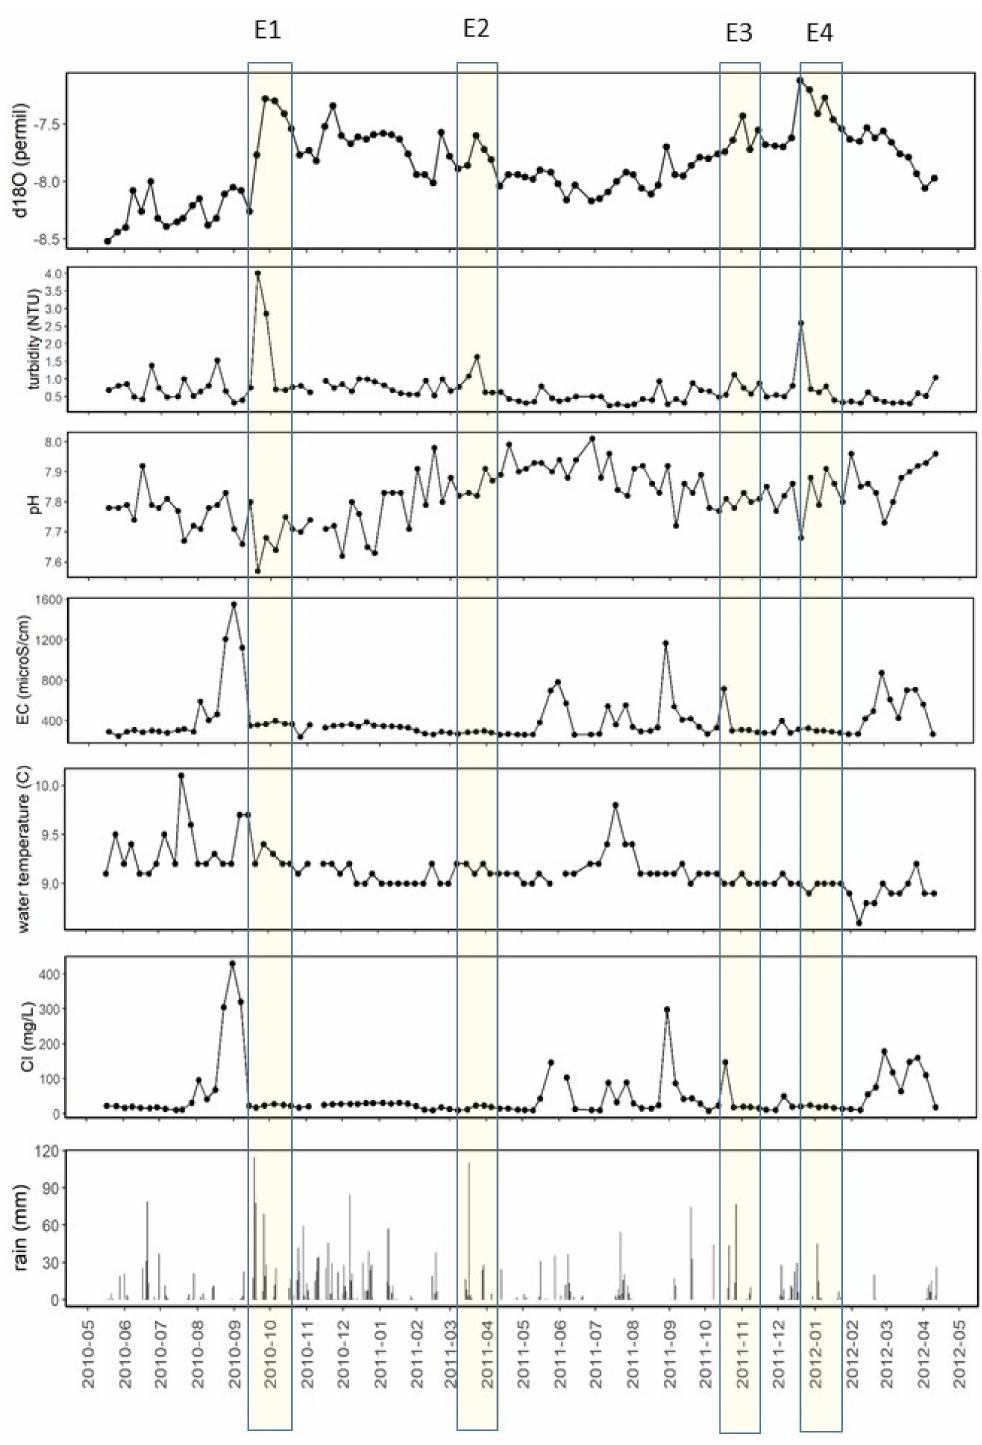
Figure 10. Time series of δ 18 O, turbidity, pH, electrical conductivity, temperature, and Cl con- tent of Dobrica spring (DBC) against daily rain quantities at CMHS meteorological station Kukul- janovo. E1–E4—isolated events in which the presence of newly infiltrated precipitation in the system was